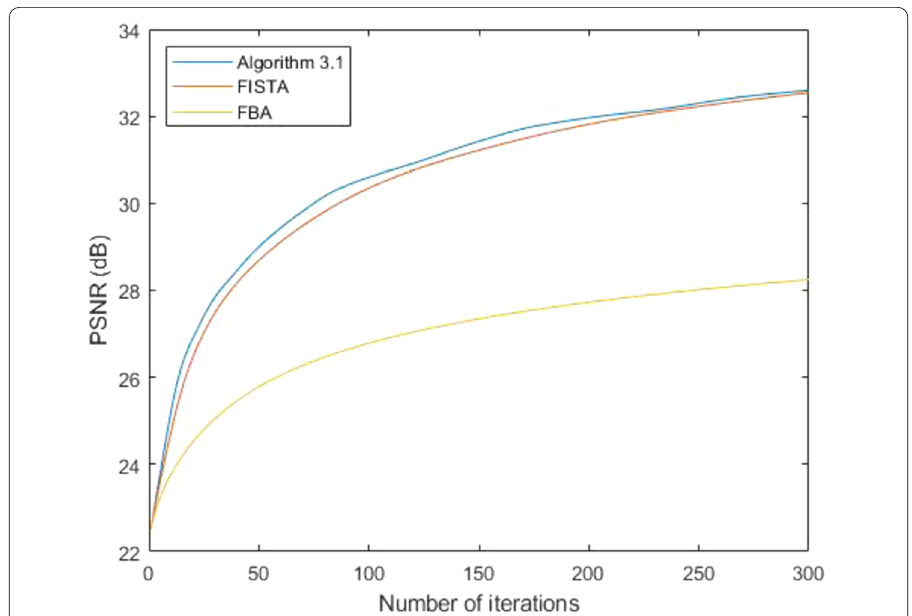
Figure 2 The graphs of PSNR of each algorithm for Wat Boonyawad